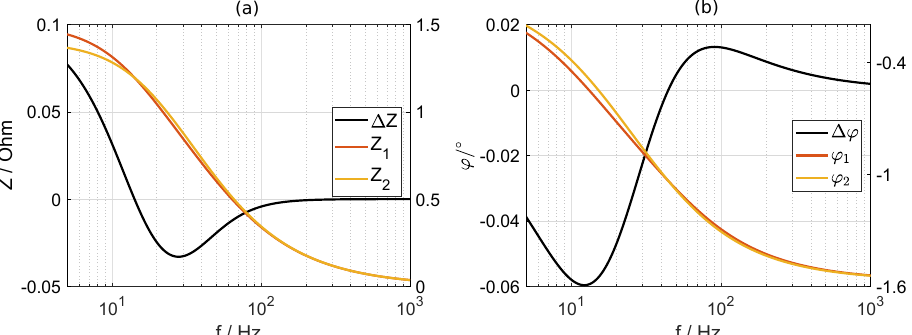
Figure 8. Simulation results of the introduced RC -element model. ( a ) Z 1 and Z 2 each represent the total impedance of two RC -elements and ∆ | Z | = | Z 1 | − | Z 2 | . The corresponding phases are depicted in ( b ).